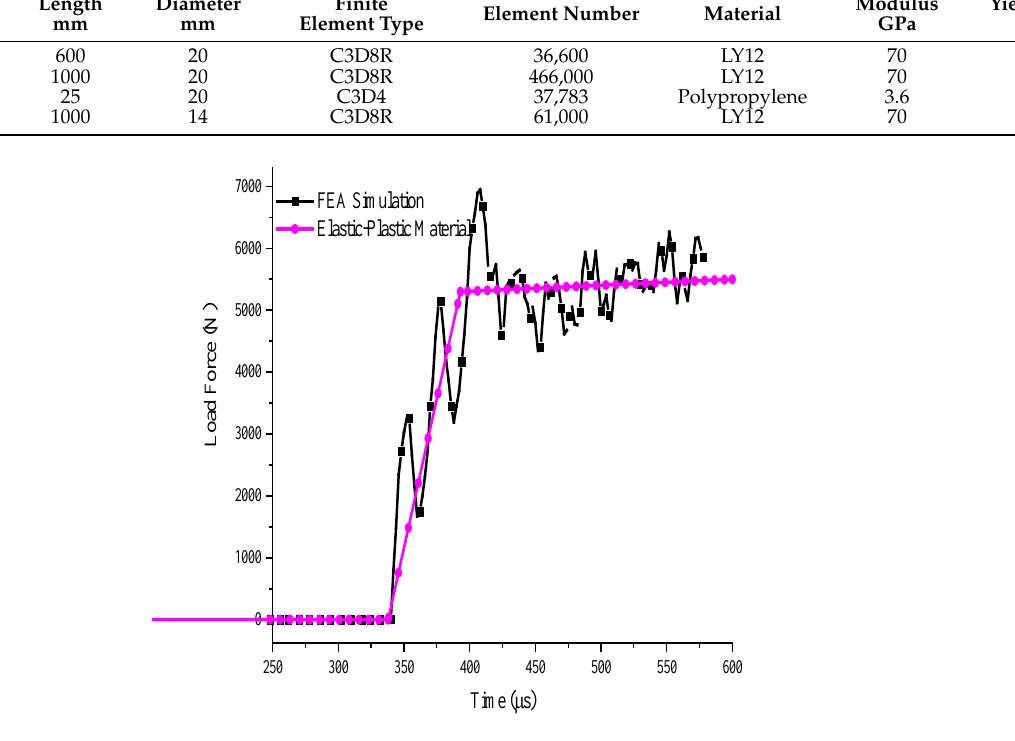
Figure 9. FEA result of PP SCS: load–time curve.